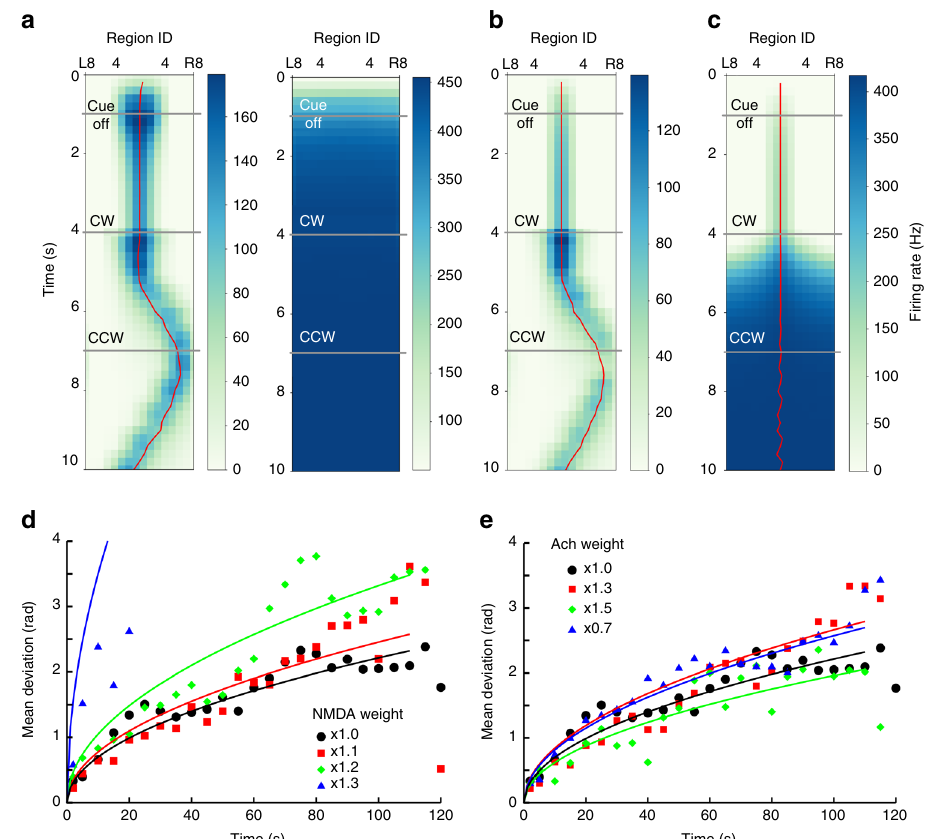
Fig. 7 The impact of synaptic kinetics on spatial orientation memory in the full model. The NMDA receptors play a crucial role in the dynamics of the model. We tested how NMDA-speci fi c kinetics in fl uences the maintenance of the activity bump using the same task as in Figs. 5b – i and demonstrated the result in region-based fi ring rate plots. a The model circuit worked with a synaptic time constant as small as 50 ms ( left ) but failed to produce any activity bump with a much smaller time constant such as 10 ms ( right ). Note that reducing the time constant leads to a smaller synaptic current; hence we needed to compensate the reduced current by scaling up the synaptic weight. The best scaling factor was found to be 1.2 when the time constant equals 50 ms. b We removed the mechanism of magnesium block from NMDA and found that the removal produced little impact to the activity bump. c We turned off the saturation mechanism and discovered that, although a bump presented initially, it quickly disappeared after the initiation of body rotation. d We tested the model with different NMDA synaptic weights in the random walk task and measured the mean deviation (as in Fig. 6e). Each color denotes data for the mean deviation produced by the speci fi ed synaptic strength, e.q., ×1.3 for 130% of the original strength used in Fig. 6. The model worked reasonably well within a moderate range (×1.0 – ×1.2) of the NMDA synaptic strength. e For comparison, we further tested how the strength of the cholinergic synapse (Ach) in fl uences the model performance and found that the model was insensitive to the change of the synaptic weight. To visualize the data in d and e , we fi t the data to a square-root function as represented by the and ring neurons (Figs. 1d, 2b, and Supplementary Table 1). In the present study, we de fi ned two levels of morphological classi fi cation: class and type. Each neuron type represents a unique innervation pattern at the regional level, while a neuron class is a collection of neuron types with similar innervation patterns at the neu- ropil level. Neurons in the EIP class innervate both C and P rings with their dendritic domains in three consecutive regions of each ring, while they innervate only one region in the PB. Note that, as reported by Wolff et al. 33 , EIP0 and EIP17 innervate only one EB region, EB R8 and L8, respectively. The reason why these two neuron types exhibit such atypical innervation patterns is unclear. But their existence does not affect the neural activity in EB R8 and L8 of the simulated EB – PB circuit. Neurons in the PEI class innervate one PB region with their den- dritic domains, while they innervate two consecutive regions in the C-ring of the EB with their axonal domains. Neurons in the PEN class are similar to those in the PEI class but with axonal innervation in the P-ring of the EB. The ring neurons project from the lateral triangle (LT, or bulb) to all regions in the EB, and different ring-neuron types innervate different rings of the EB 32, 35, 36, 53 . Because EB and PB neurons are found to express the VGlu driver 54, 55 , and because NMDA receptors in the EB play a crucial role during a memory task 56 , part of the neuronal interaction in the EB – PB circuits may be mediated through NMDA receptors. Therefore, we hypothesized that the mutual excitation between EIP, PEI, and PEN is mediated through NMDA receptors. In addition, constituents of acetylcholine machinery are also widely expressed in EB and PB 32,57 , and in the projection neurons from upstream regions to the PB 32 . Therefore, we modeled the visual inputs with cholinergic synapses. We acknowledge the possibility that the